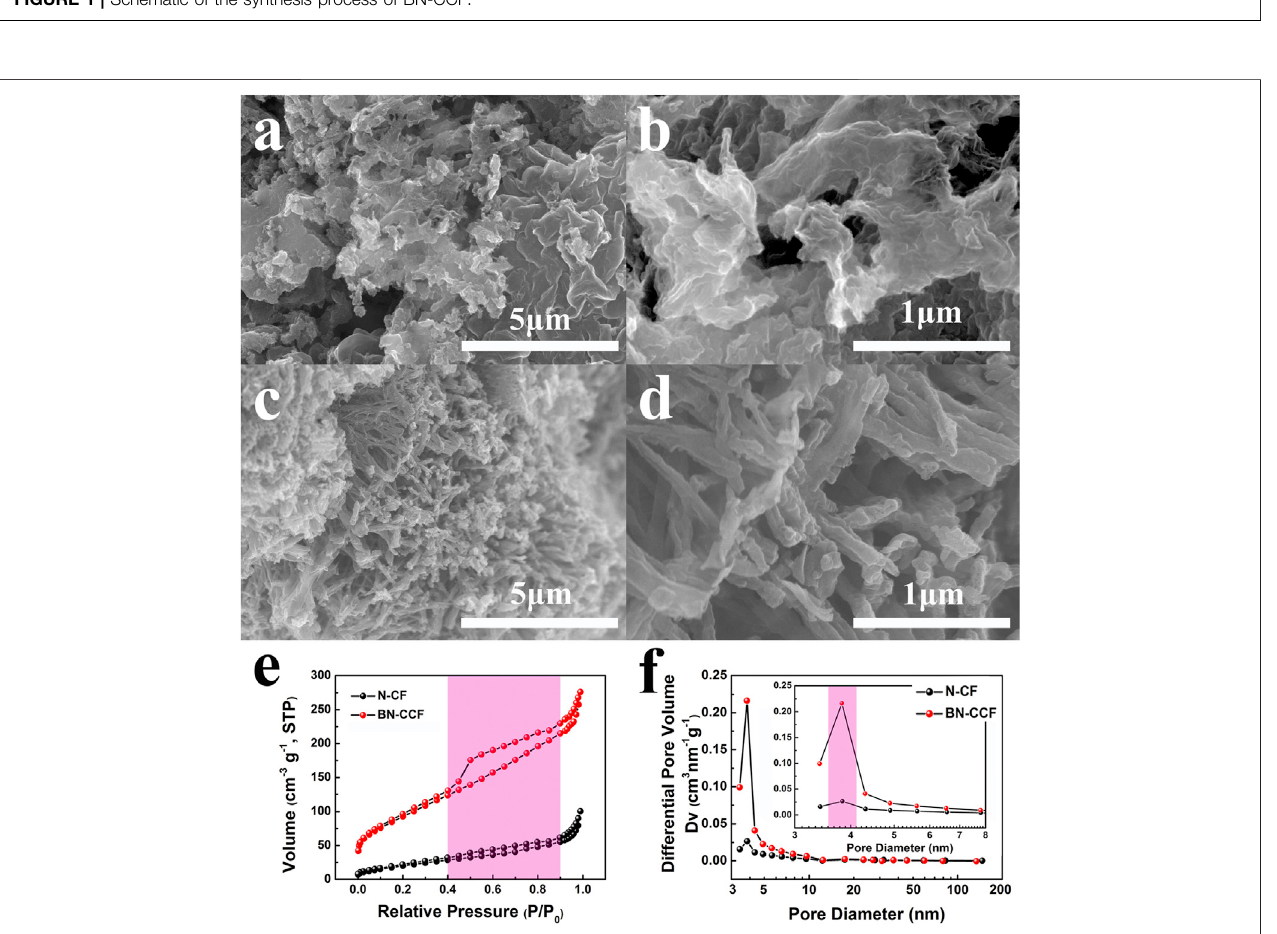
FIGURE 2 | SEM images of (A,B) N-CF and (C,D) BN-CCF (E) Nitrogen adsorption-desorption isotherms and (F) pore size distribution curves of N-CF and BN-CCF.